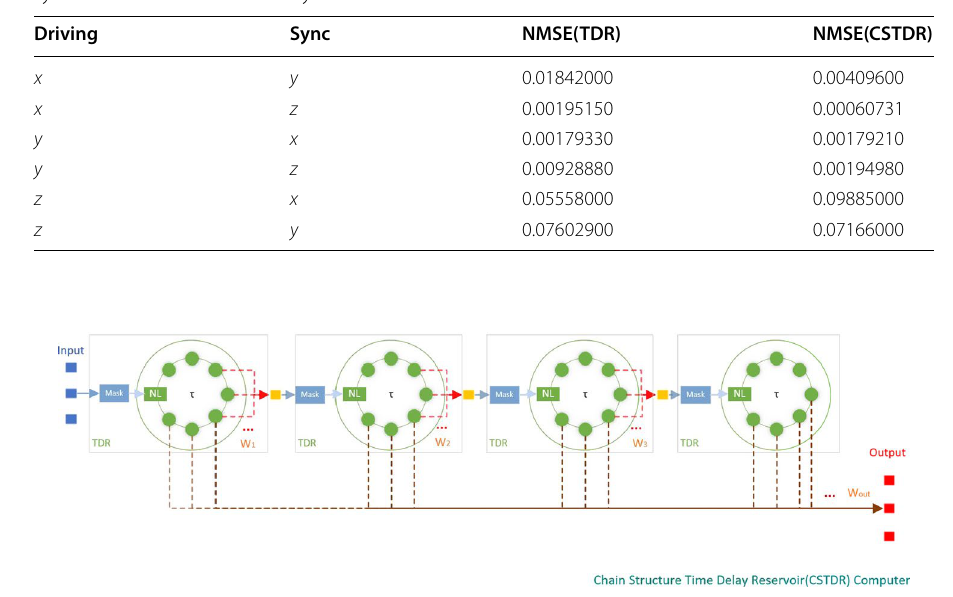
Fig. 2 The proposed chain-structure time-delay reservoir (CSTDR)